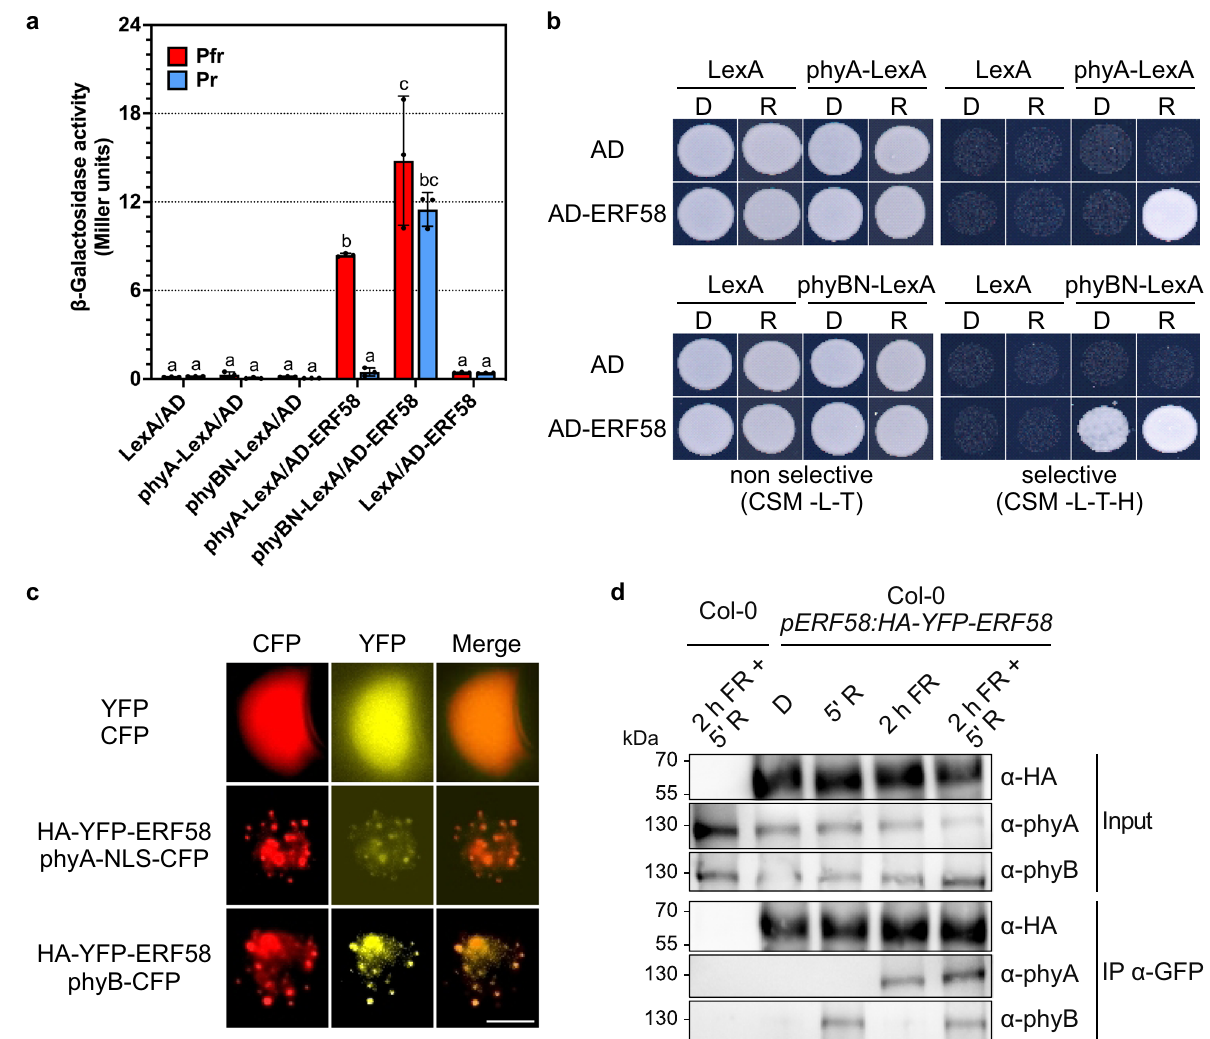
Fig. 1 ERF58 interacts with phyA and phyB. a Y2H protein-protein interaction assay. Full-length phyA or the N-terminal half of phyB (phyBN) fused to LexA and ERF58 fused to the GAL4 AD were expressed in yeast. Yeast cells were grown in chromophore (PCB)-supplemented medium, exposed to R or FR light for 5 min to convert phytochromes to Pfr or Pr, and incubated in the dark for another 4 h. β -Gal activity was then measured using an ONPG assay. Bars show mean β -Gal activity of three replicates ±SD. Different letters indicate signi fi cant differences as determined by two-way ANOVA followed by post-hoc Tukey ’ s HSD test; p < 0.05. b Y2H growth assay. phyA- or phyBN-LexA and AD-ERF58 were expressed in yeast. Yeast cells were grown on CSM -L-T plates or CSM -L-T-H plates supplemented with PCB. Plates were incubated in the dark (D) or R light (R). c Co-localisation of ERF58 with phyA and phyB in tobacco. p35S:HA-YFP-ERF58 and either p35S:PHYA-NLS-CFP or p35S:PHYB-CFP were transiently co-expressed in tobacco leaf epidermis cells by agro in fi ltration; empty p35S:YFP and p35S:CFP vectors were used as control. YFP and CFP signals were detected by epi fl uorescence microscopy. Scale bar represents 5 μ m. d Co-immunoprecipitation of phyA and phyB with ERF58. Stable transgenic Arabidopsis lines expressing pERF58:HA-YFP-ERF58 in Col-0 background were used for Co-IP; Col-0 was used as negative control. Three day old dark-grown seedlings were treated for 5 min with R light, for 2 h with FR light, for 2 h with FR light followed by 5 min R light, or kept in the dark and used for Co-IP. Eluate fractions were analysed by SDS-PAGE